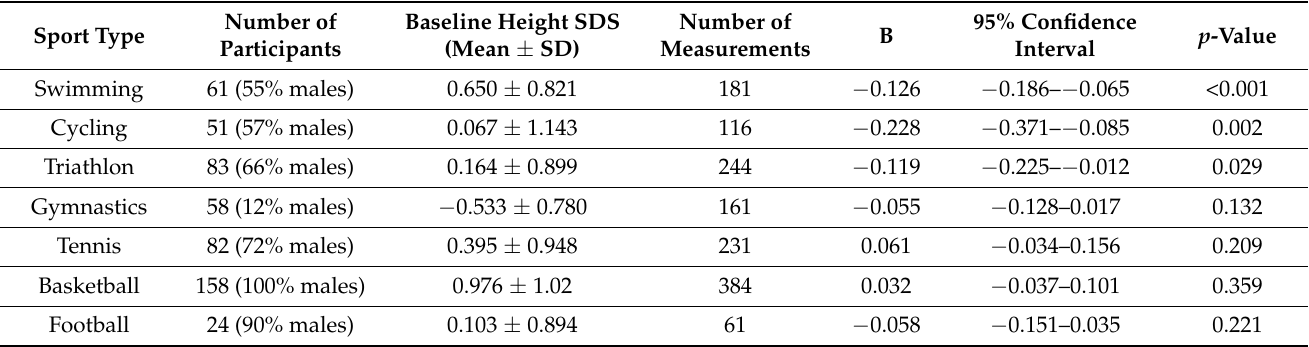
Table 2. Changes in height SDS over time calculated from generalized estimating equations, ad- justed for age at first visit and sex, in athletes with repeated measurements from the most common sport